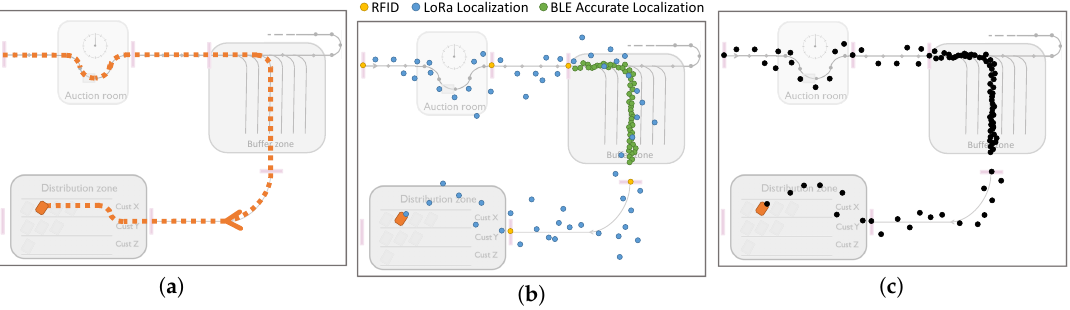
Figure 11. Use Case I: Fine tracking for trolleys. ( a ) Real track of the moving trolley; ( b ) Location measurements from three technologies; ( c ) Measured track after filtering.